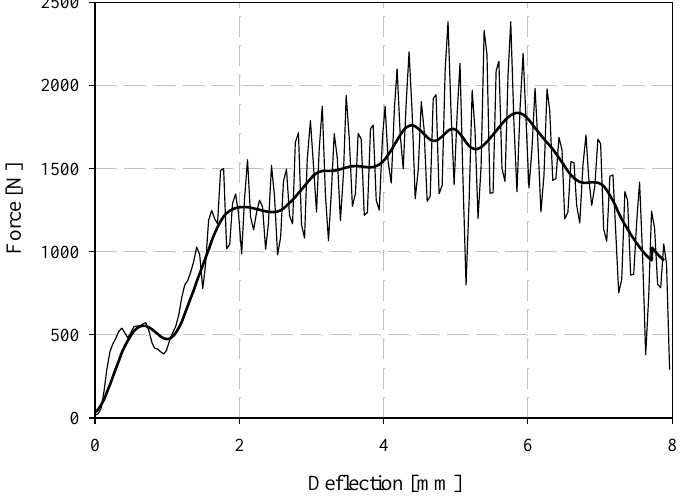
Figure 15. Filtered and unfiltered force-deflection response for low-velocity impact specimen ISOS1LV.